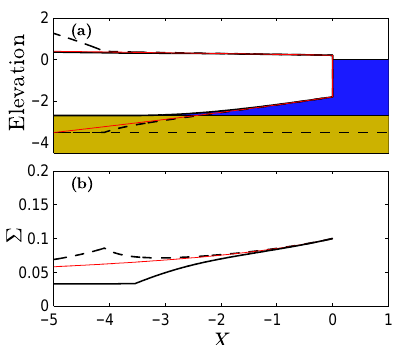
Figure 9. Solutions for a long shelf, same plotting scheme and pa- rameter values as in Fig. 8. The dashed line shows the solution with (cid:48) = 125 and H f = 3 . 9, the solid line shows (cid:48) = 0 and H f = 3. Both are marked with red diamonds in Fig. 7a. The red line shows the so- lution to the near-calving-front boundary layer Eq. (25). All three solutions agree closely with this boundary layer near the calving